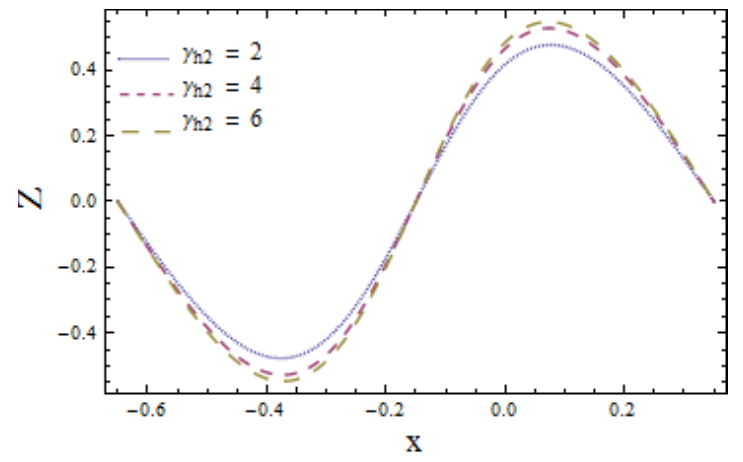
Figure 10. Heat transfer Z versus y for γ h 2 when (cid:101) = 0.2, t = 0.1 and γ h 1 =